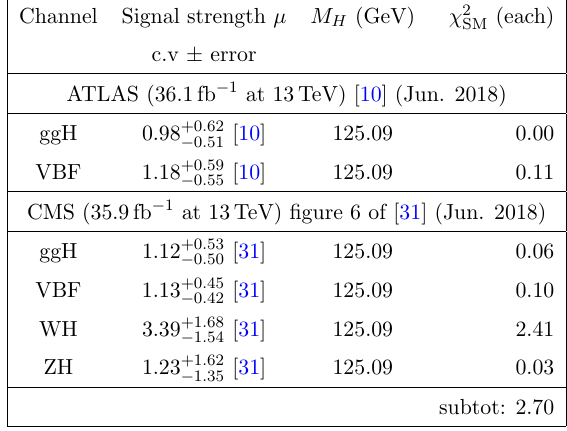
Table 13 . (LHC: 13 TeV) The same as table 9 but for H ! (cid:28) + (cid:28) (cid:0) .